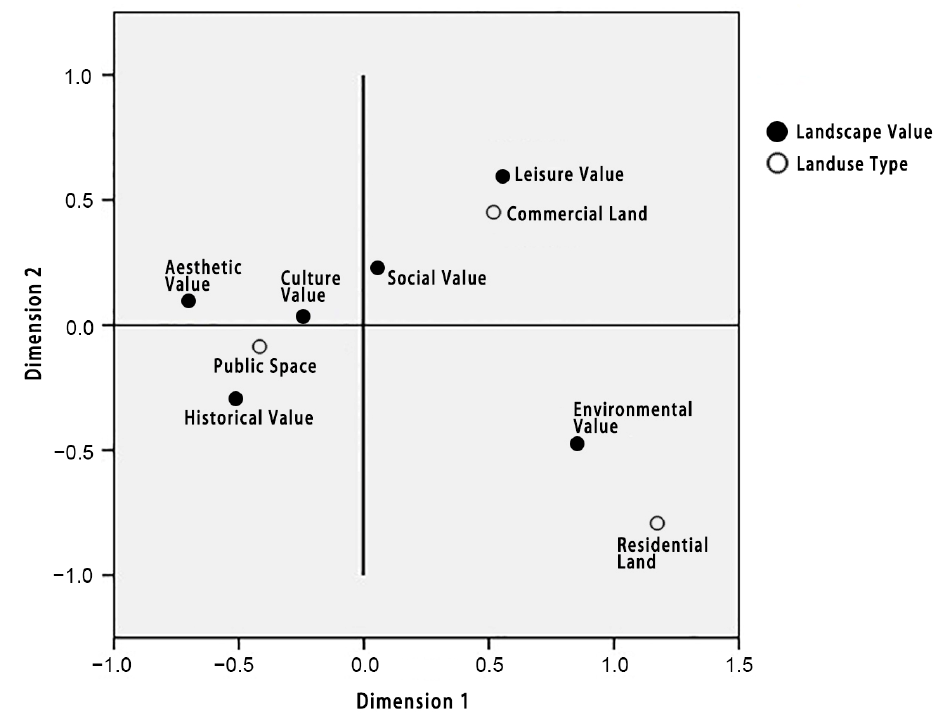
Figure 4. Correspondence analysis of landscape values and land use types.